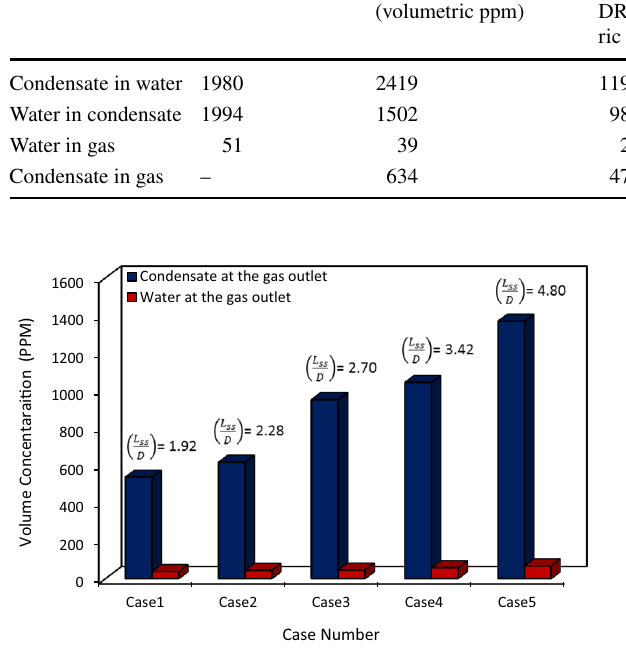
Fig. 11 Simulated mass distribution of condensate and water droplets at the condensate and water outlets of Cases